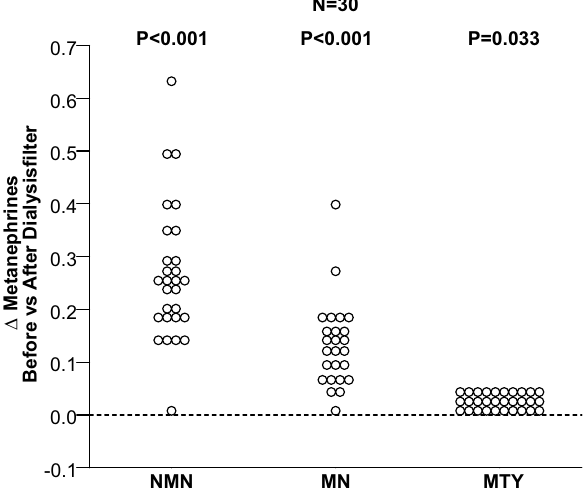
Figure 2. Δ of plasma concentrations of free normetanephrine (NMN), metanephrine (MN) and 3-methoxytyramine (3-MTY) before the blood enters the filter versus after leaving it.